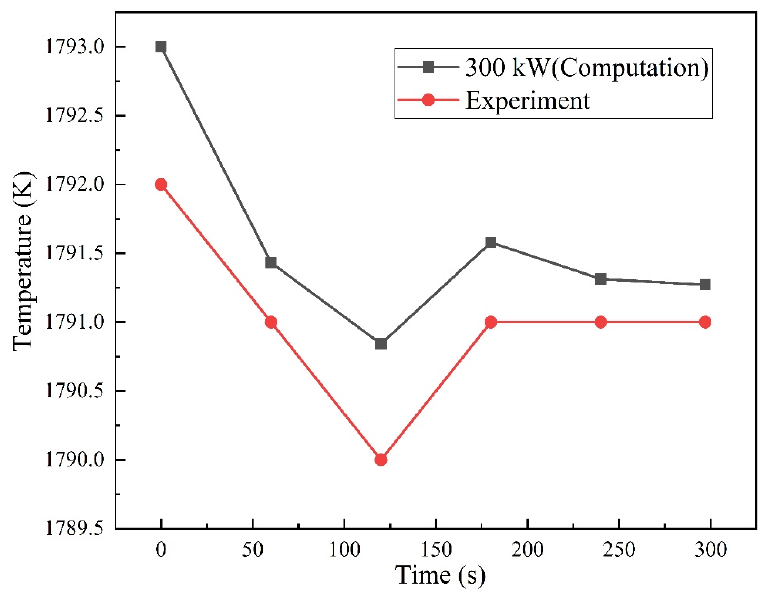
Figure 3. Comparison of the temperature variation between the experimental and calculation results.